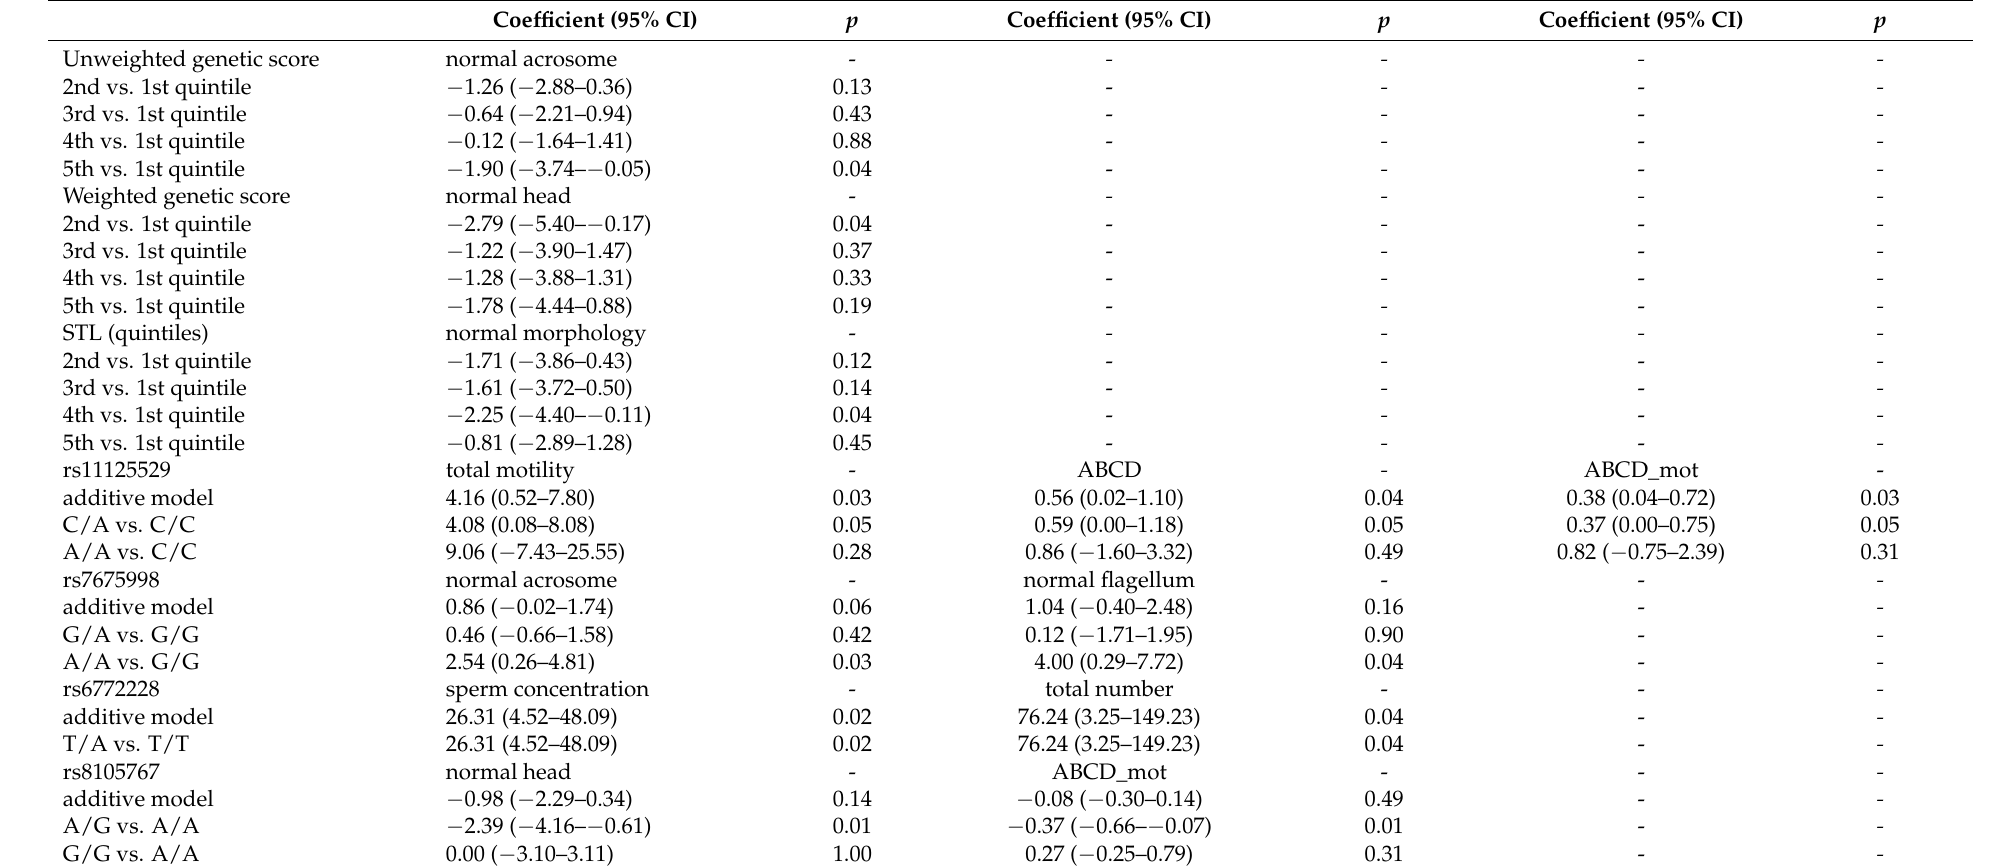
Table 5. Statistically significant associations of log-transformed STL, teloscores, and SNPs with sperm